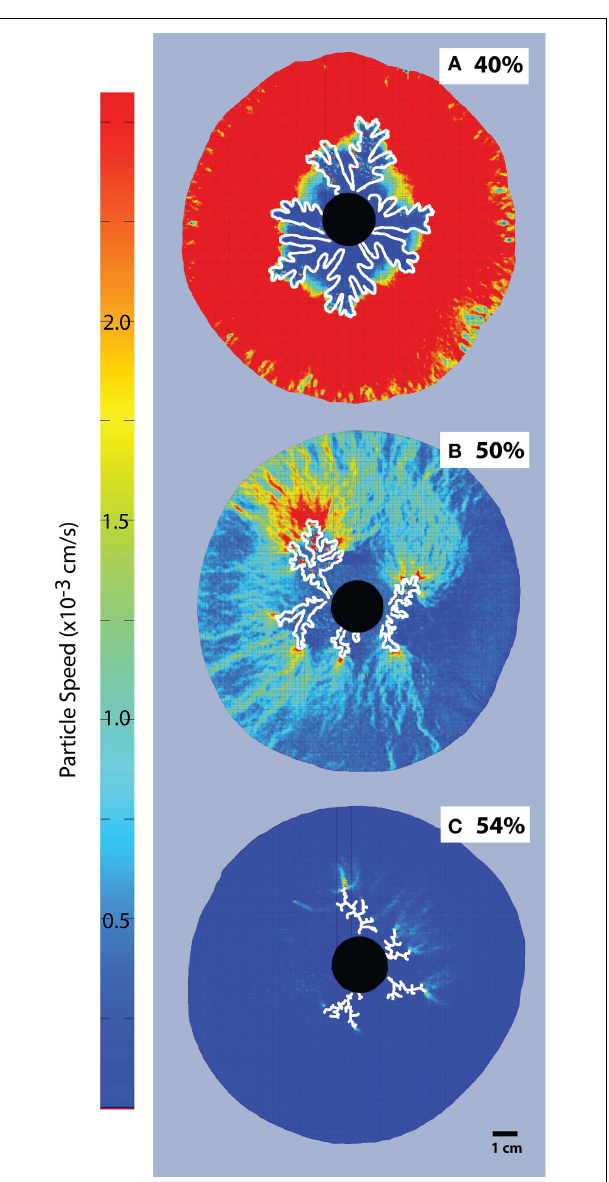
FIGURE 5 | Particle Image Velocimetry on bubble injection experiments in a small-gap parallel plate geometry. Particle concentrations are (A) 40% or φ = 0 . 74 , (B) 50% or φ = 0 . 93 , and (C) 54%, or φ = 1 . The black disk in the center is the injection point, and fingers grow radially (outlined in white). The color scale is constant for all images, for better comparison. The areas with most displacement appear red and the dark blue areas are essentially immobile (Viscosity ≈ 10 Pa s, air influx =